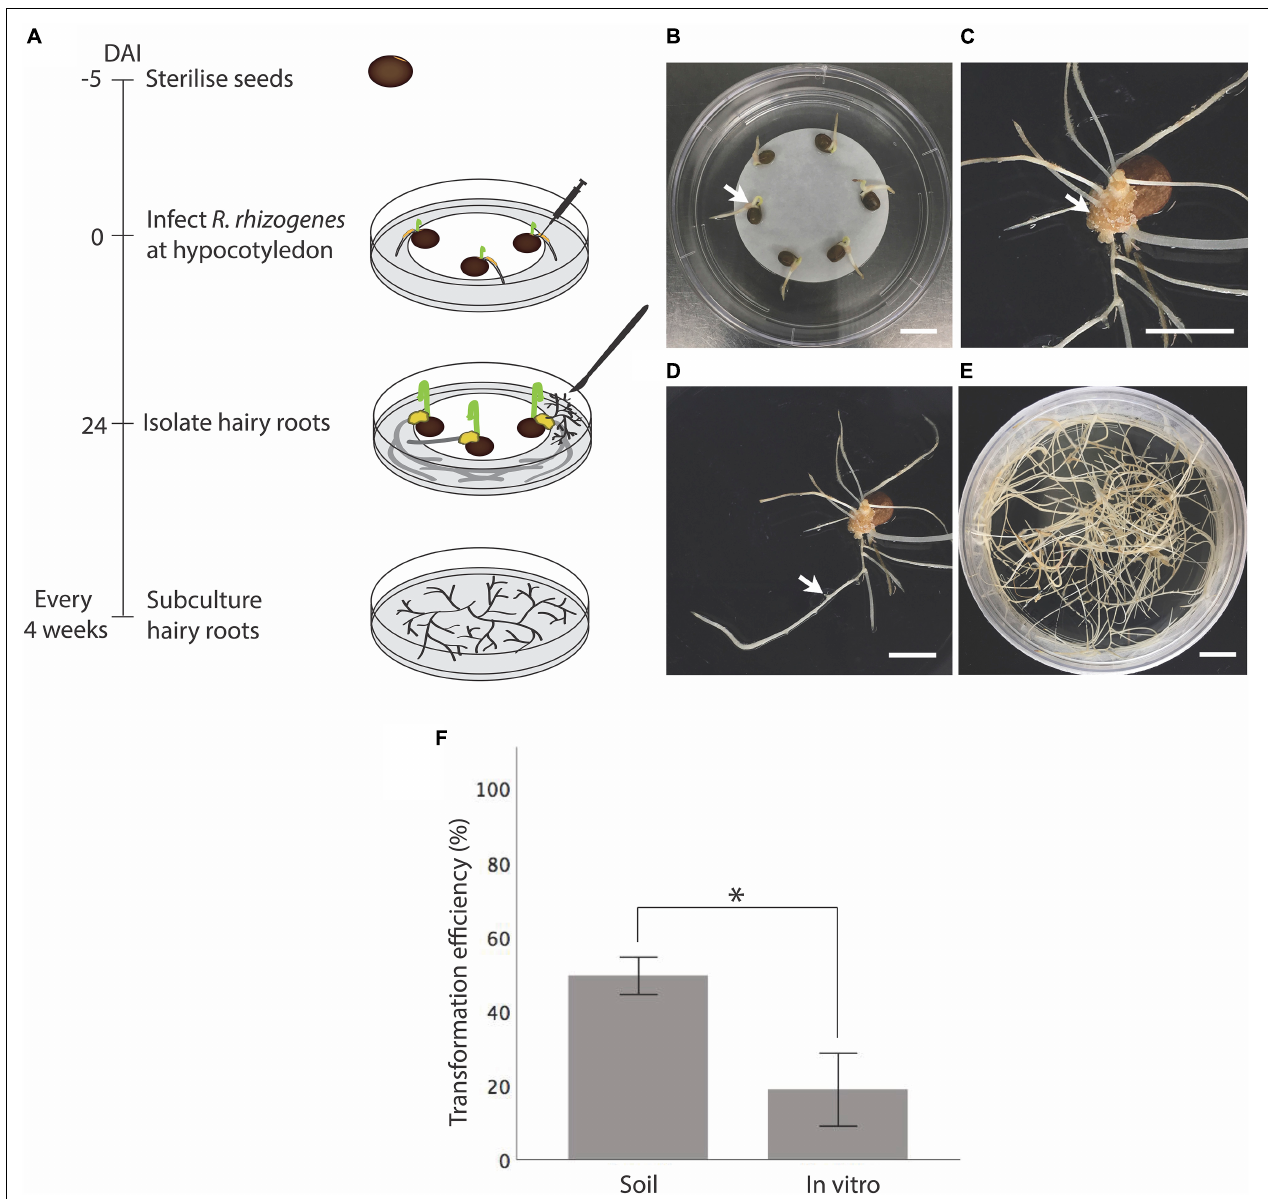
FIGURE 2 | In vitro hairy root induction from vetch hypocotyl by R. rhizogenes K599 using the stabbing method. (A) Timeline for in vitro hairy root induction by R. rhizogenes . On day 1, sterilized seeds were sown on a plate containing inoculation (RGM_NoSuc) medium and placed at 25 ◦ C until germination. On day 5, the seedling hypocotyl region was inoculated with R. rhizogenes K599 using the stabbing method and then cultured on inoculation medium with a filter paper (optional) under fluorescent light at 25 ◦ C. Twenty-four days after the infection (DAI), hairy roots were isolated and subcultured onto RGM_3xSuc medium with 25 mg/L meropenem. Hairy roots were subcultured every 4 weeks onto fresh medium. (B) Inoculation of seedling hypocotyl regions (white arrow) with R. rhizogenes. (C) Twenty-four DAI, callus developed from the inoculated region (white arrow). (D) A hairy root protruded from the callus (white arrow). Early lateral root formation in the hairy root created a highly branched structure, which could help to distinguish hairy roots from wild type roots. (E) Hairy roots 45 DAI were highly branched. (F) On soil and in vitro hairy root induction efficiency when using seedling hypocotyl stabbing method ( n = 20 for each medium). ∗ Statistically significant at